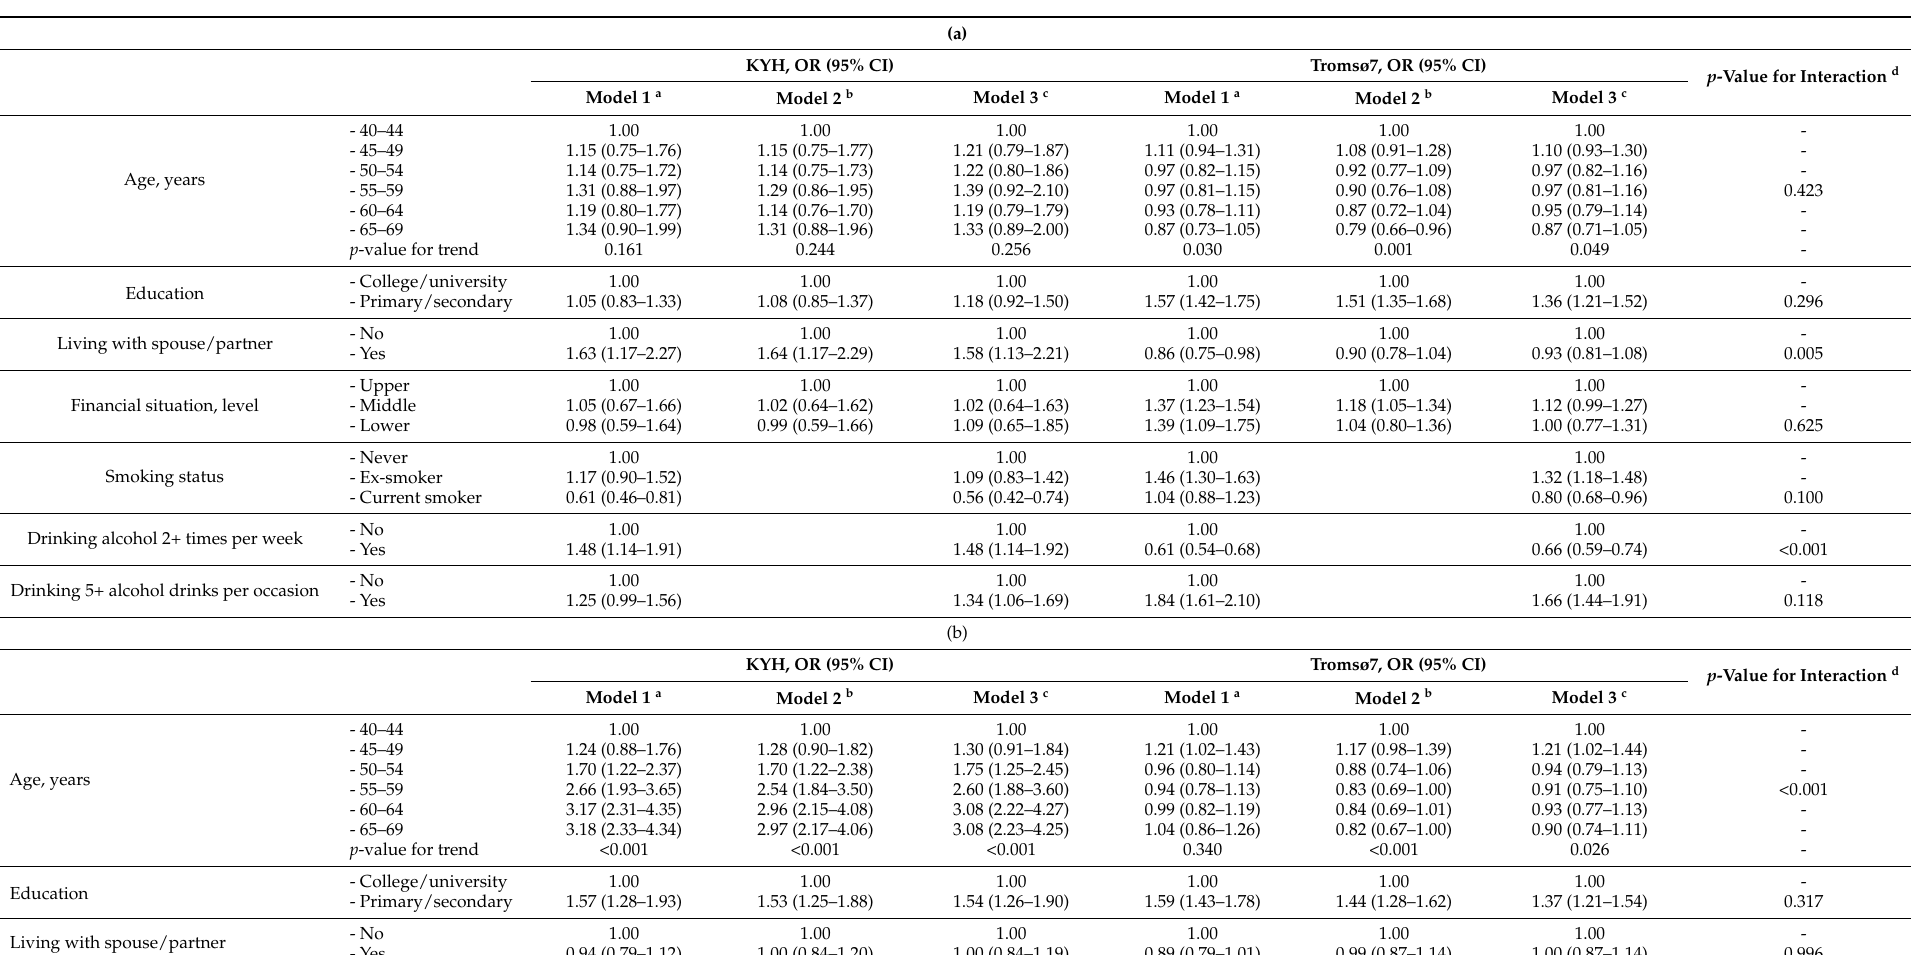
Table 2. (a). Associations of socio-demographic and behavioral characteristics with general obesity (BMI ≥ 30 kg/m 2 ) by study among men. (b) Associations of socio-demographic and behavioral characteristics with general obesity (BMI ≥ 30 kg/m 2 ) by study among